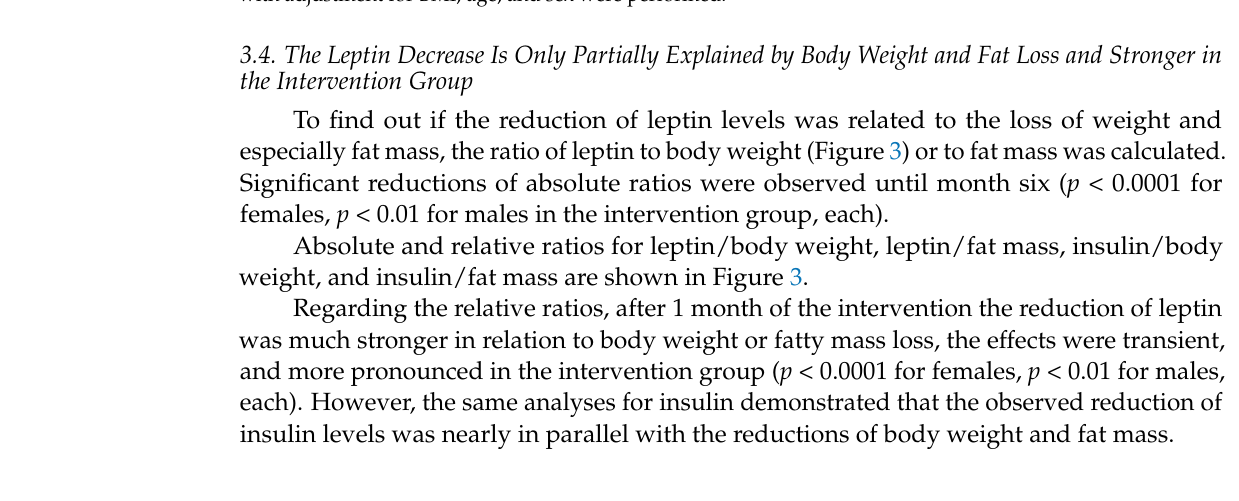
Bold p -values represent statistical significance. Spearman correlations and multivariable linear regression analyses with adjustment for BMI, age, and sex were